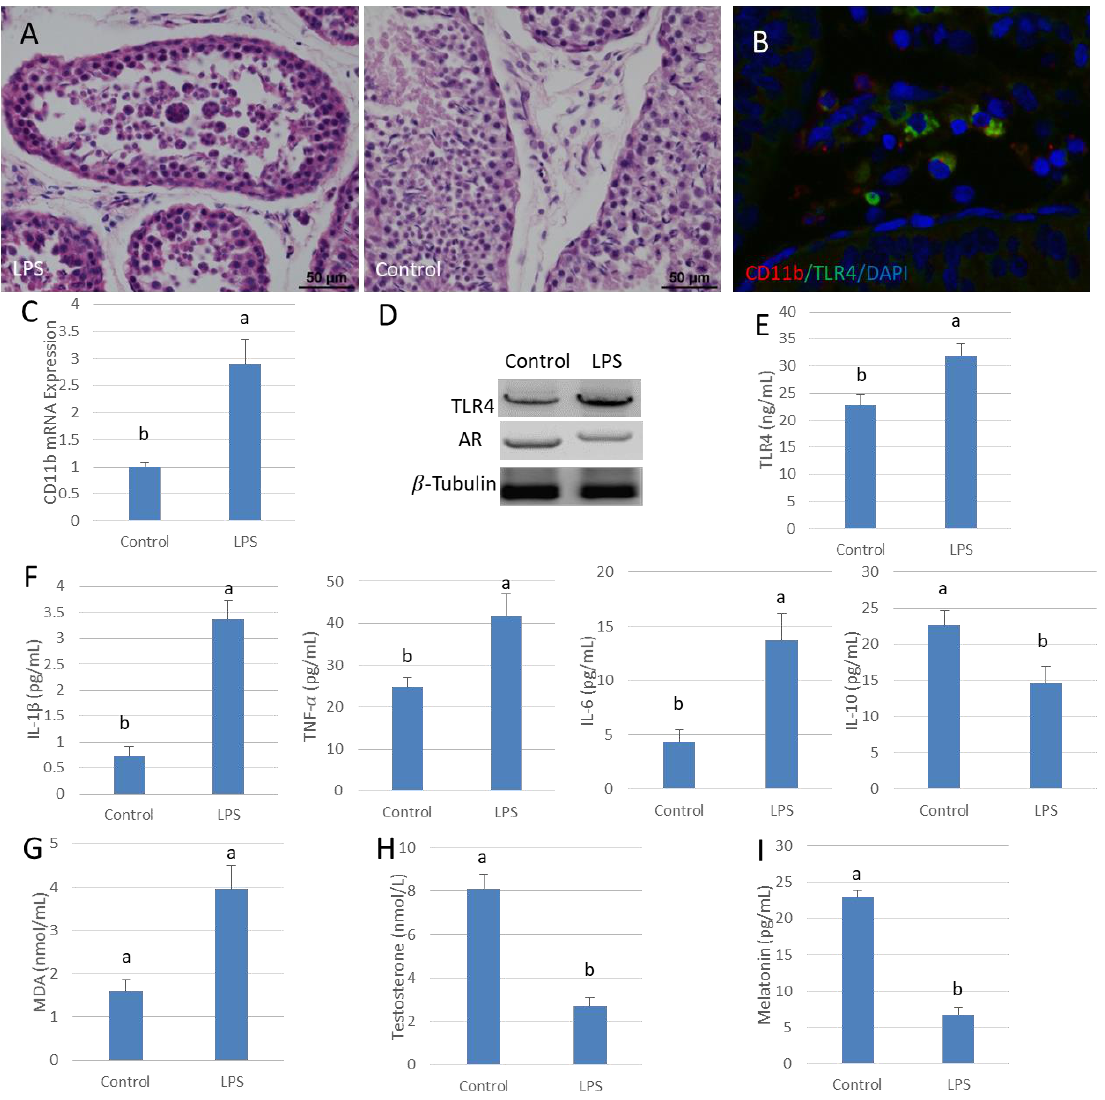
Figure 1. Lipopolysaccharide (LPS) reduces testosterone content in sheep testis. ( A ) Testis HE stains. Testes injected with saline were used as the control. Spermatogenesis was disturbed in the LPS injection group (left). ( B ) Testicular tissue immunofluorescence, CD11b (Red), TLR4 (Green) and DAPI (Blue). ( C ) CD11b gene mRNA expression in the LPS injection group. ( D ) Western blot analysis of TLR4 and AR in testis. ( E ) and ( F ) ELISA testing of TLR4, IL-1β, TNF-α, IL-6 and IL-10 protein expression. ( G ) MDA content in the LPS infected testis group. ( H ) and ( I ) ELISA detection of testosterone and melatonin concentrations. Data are shown as mean ± SEM. Different superscript letters (a, b) in each column represent statistically significant differences ( p < 0.05).